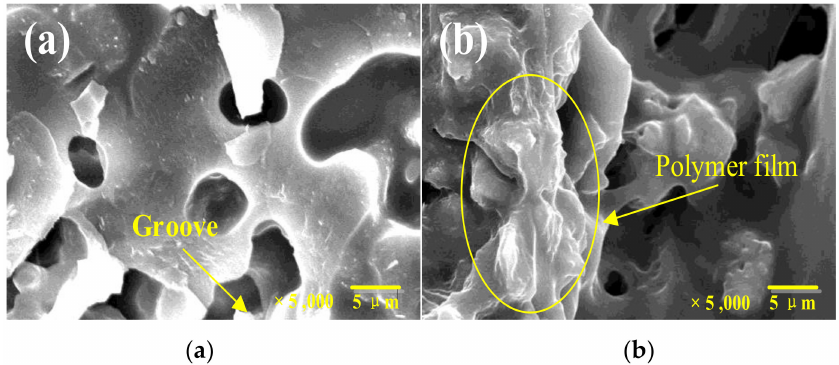
Figure 10. Secondary Electron images of damping aggregate: ( a ) lightweight aggregate and ( b ) lightweight aggregate presaturated with